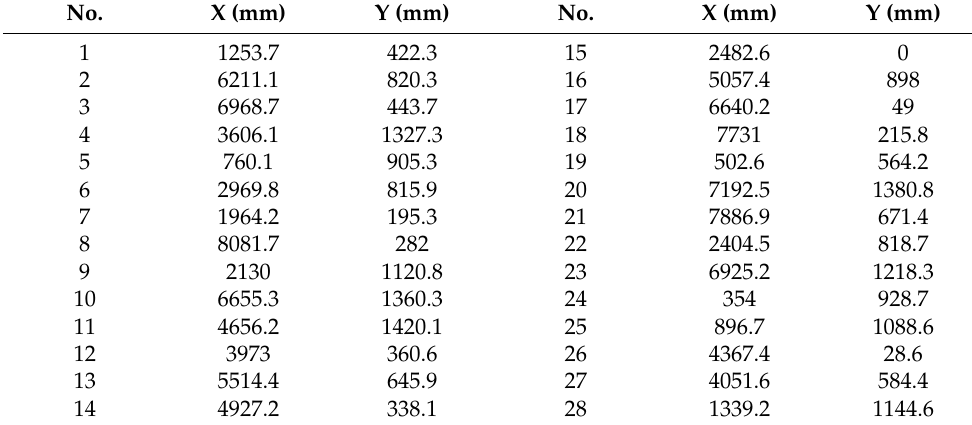
Figure 7. IPSOARW-based measurement point optimization for the bridge deck. Table 6. Optimized position coordinates of bridge deck measurement points based on the IPSOARW. No.